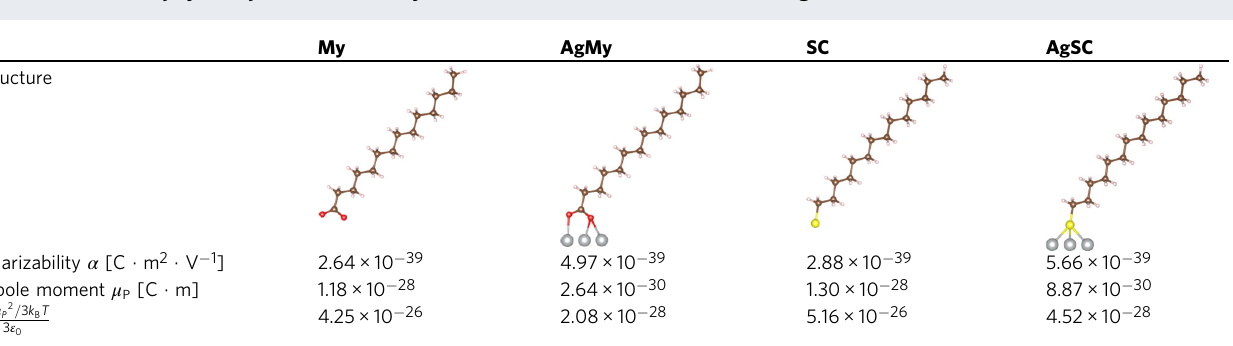
Table 1 Calculated physical parameters of My and SC molecules with and without Ag atoms.